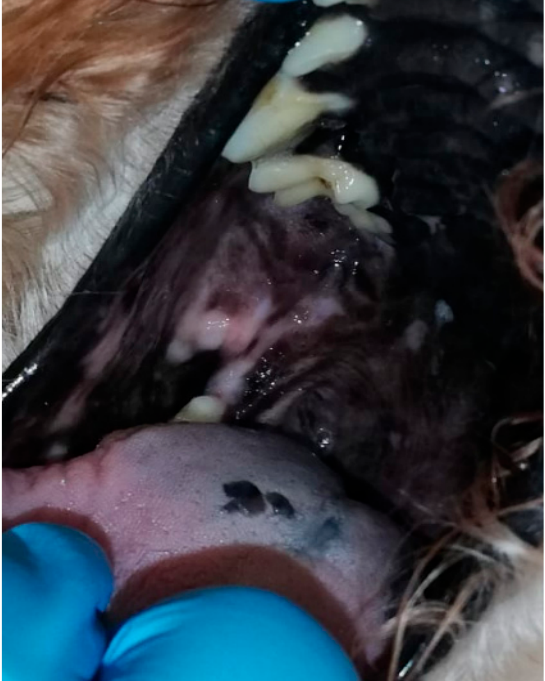
Figure A3. Appearance of the mass 3 months after completion of immunotherapy.